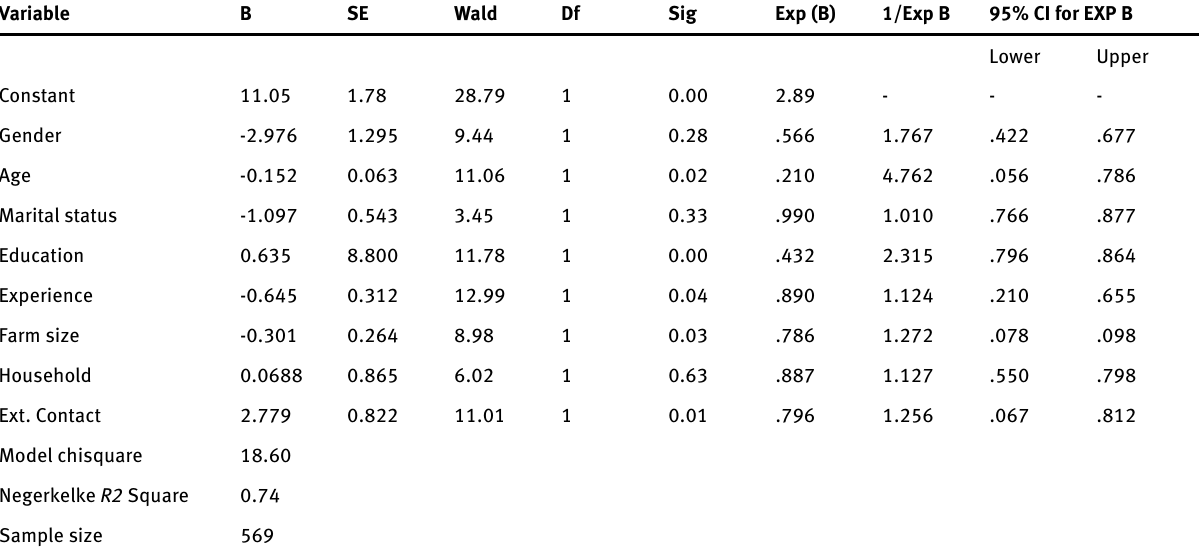
Table 9: Logit Regression result of socio-economic variables affecting famers Knowledge Variable B